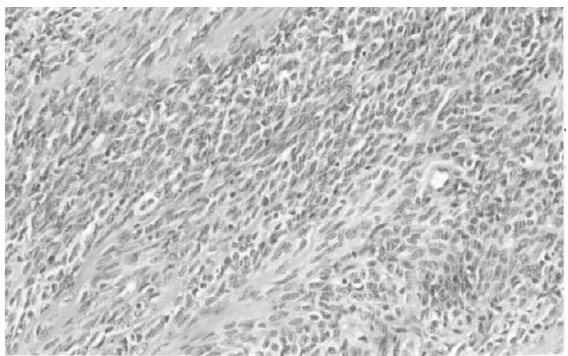
Fig. 2. Focally an hypercellular spindle cells pattern is well evident (H&E, (cid:1)